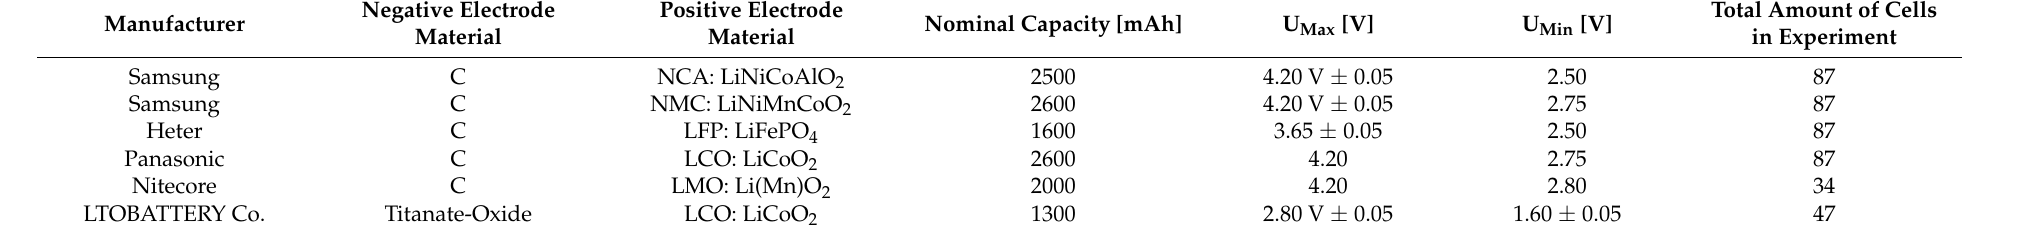
Table 1. Overview of the tested cells, values from the data sheet, respectively, with U Max being equivalent to the later used voltage definition U H .